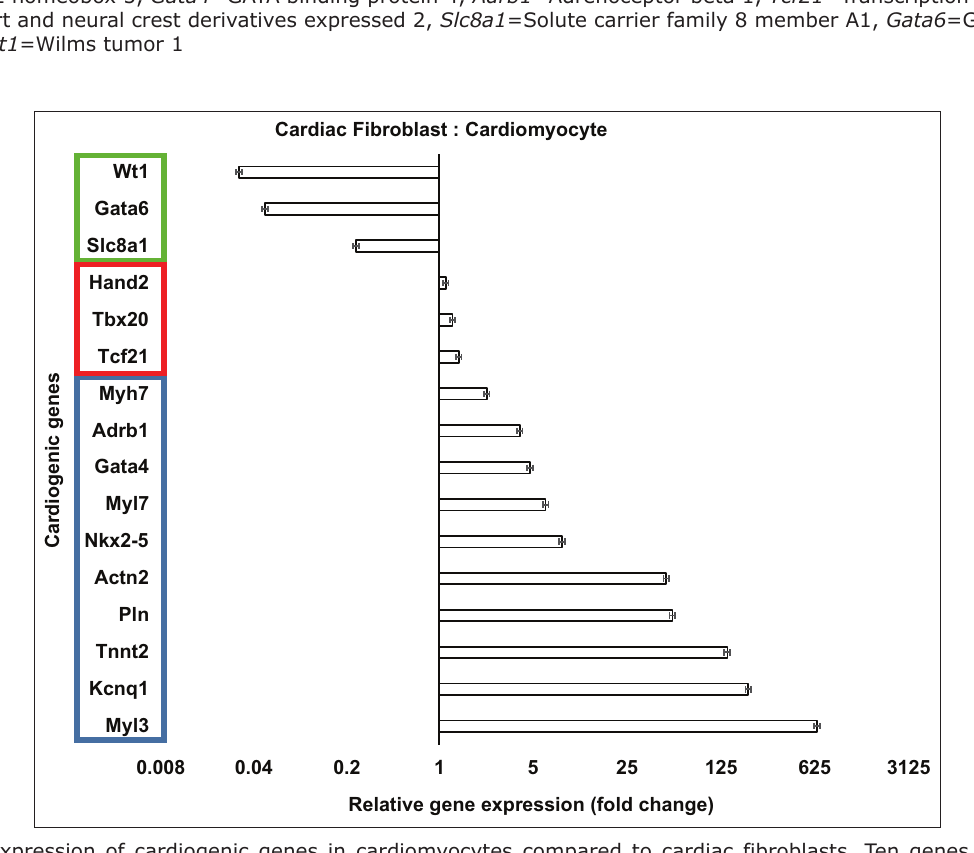
Figure-1: Expression of cardiogenic genes in cardiomyocytes compared to cardiac fibroblasts. Ten genes (in the blue rectangle) had greater expression in cardiomyocytes than in cardiac fibroblasts (p<0.01). Three expressed genes (in the red rectangle) were not different (p>0.05). Three genes (in the green rectangle) were more expressed in cardiac fibroblasts than in cardiomyocytes (p<0.01). Cell culture was done in six replications while quantitative polymerase chain reaction was done in three